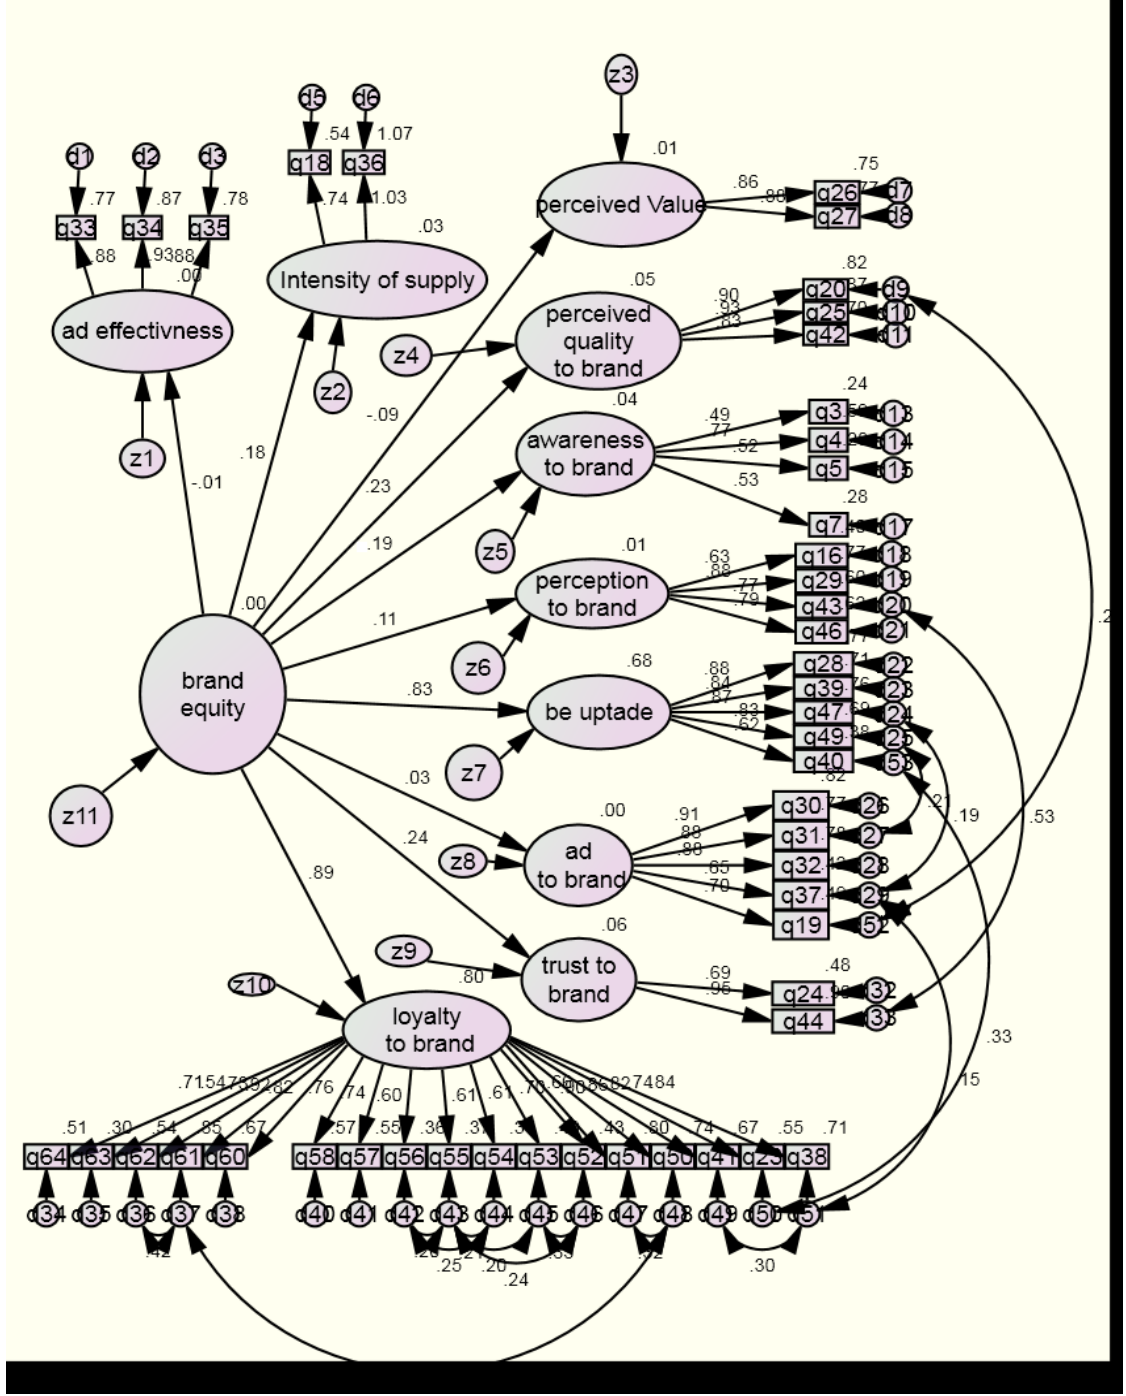
Fig. 1. The summary of standard coefficients of the implementation of structural equation